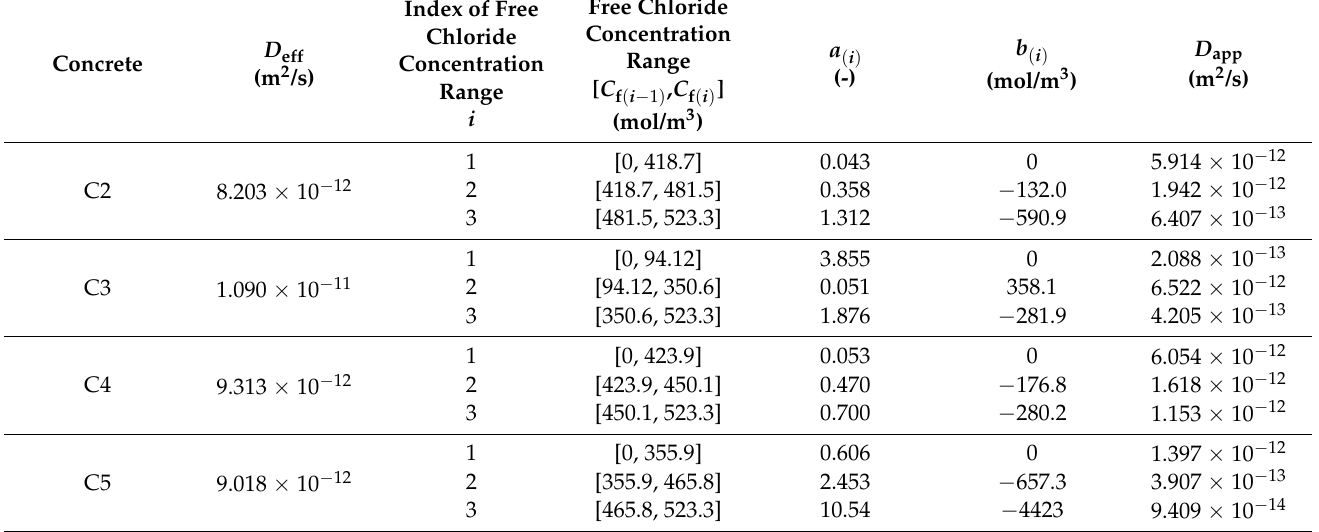
Table 7. The effective chloride diffusion coefficients ( D eff ), slopes ( a ( i ) ) and constant terms ( b ( i ) ) for the subintervals of spline function approximating binding isotherm, and apparent chloride diffusion coefficients ( D app ) in the subsequent chloride concentration ranges for concretes C2–C5. The results are obtained on the basis of data from Table